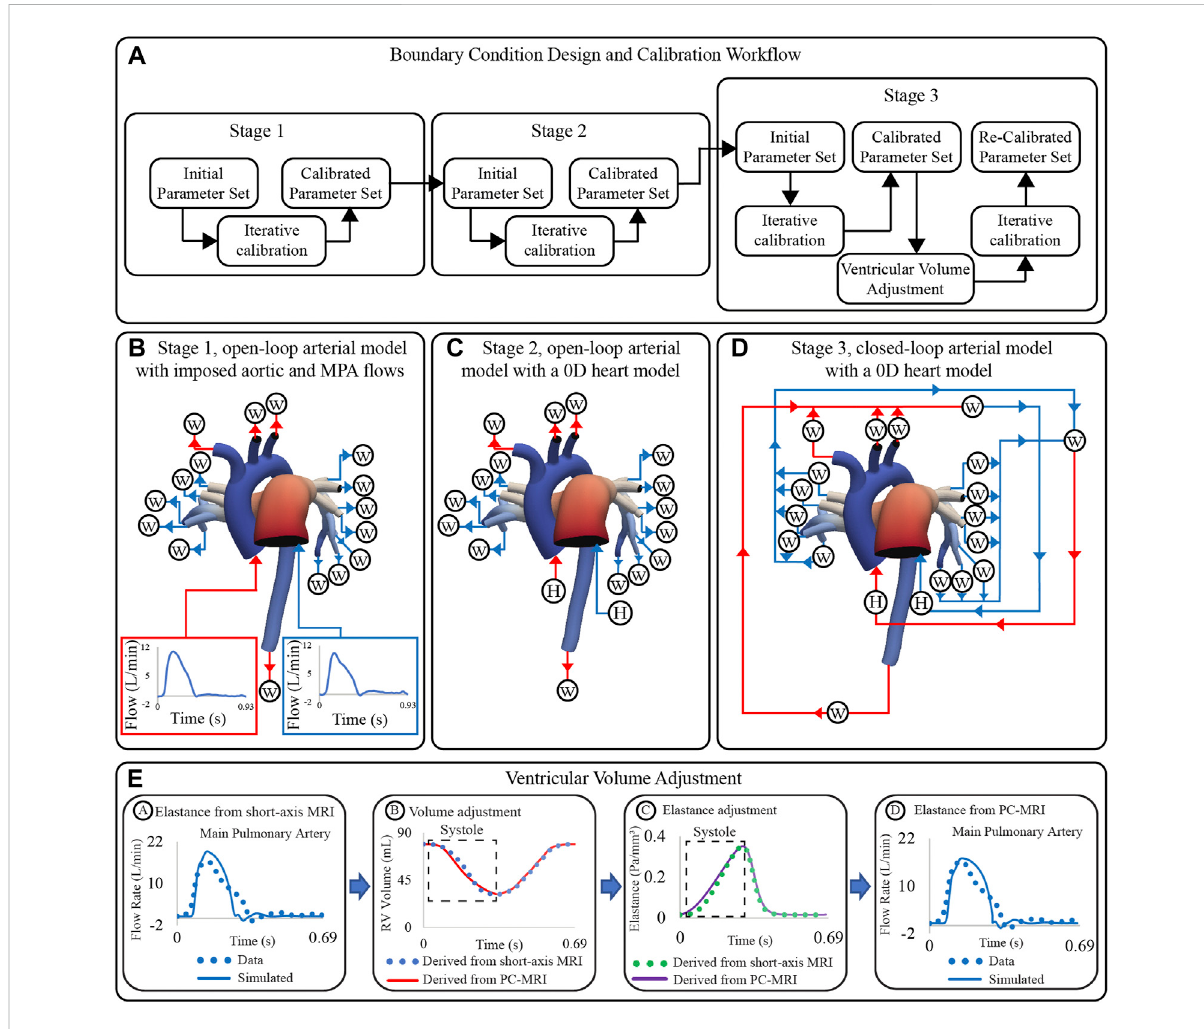
FIGURE 5 (A) Work fl ow for boundary condition design and calibration of high-resolution arterial models. (B) Stage 1: open-loop arterial model with imposed in fl ow waveforms. (C) Stage 2: open-loop arterial model with 0D heart models. (D) Stage 3: closed-loop arterial model with a 0D heart models. (E) Strategy for ventricular volume